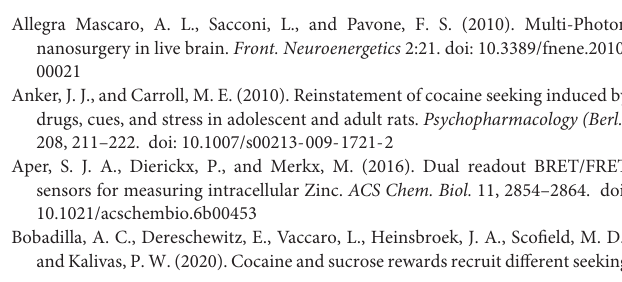
Supplementary Figure 1 | Head-restrained drug self-administration behavioral chamber. Left: each two-door cabinet has soundproofing foam (1) lining the